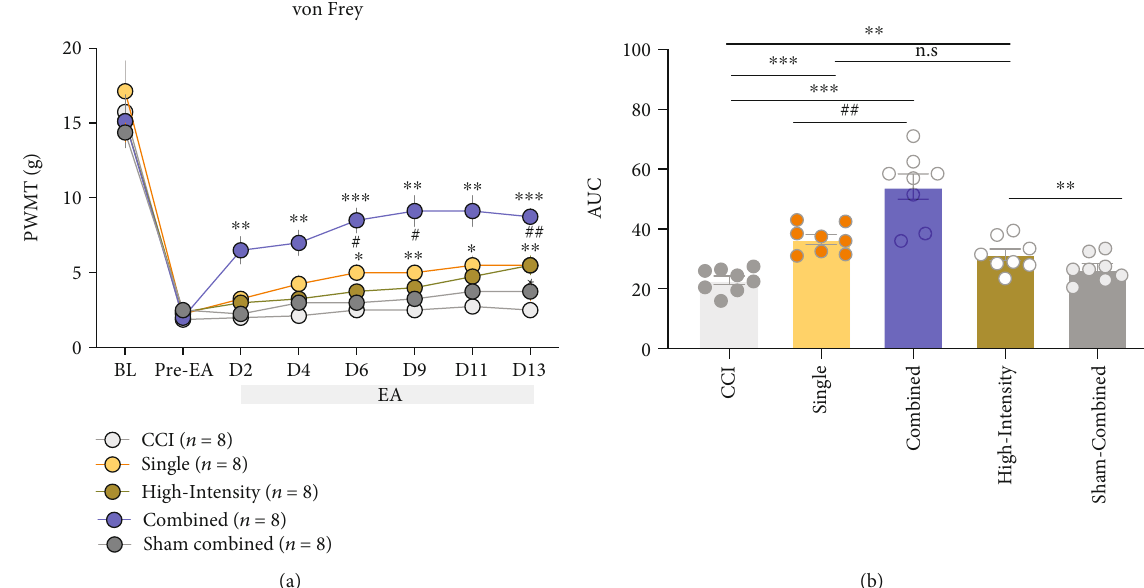
Figure 3: Increasing stimulation intensity or nonacupoint sites for single-acupoint EA did not mimic the analgesic e ff ect of the combined- acupoint EA. (a) The paw withdrawal threshold after single-acupoint EA with high-intensity treatment (6-8 mA) was higher than that of CCI group and not di ff erent from that of the single-acupoint group but much lower than that of the combined-acupoint group. EA at two nonacupoints failed to suppress pain. Two-way ANOVA followed by Bonferroni ’ s multiple comparisons test. (b) Area under the curve of graph a (from “ BL ” to D13). Student ’ s unpaired t -test. All data are mean ± SEM , ∗ P < 0 : 05 , ∗∗ P < 0 : 01 , ∗∗∗ P < 0 : 001 vs. CCI; # P < 0 : 05 , ## P < 0 : 01 vs. combined; n.s.: not signi fi cant; N = 8 in each group. BL: baseline; CCI: chronic constriction injury; EA: electroacupuncture; AUC: area under curve; PWMT: paw withdrawal mechanical threshold; vs: